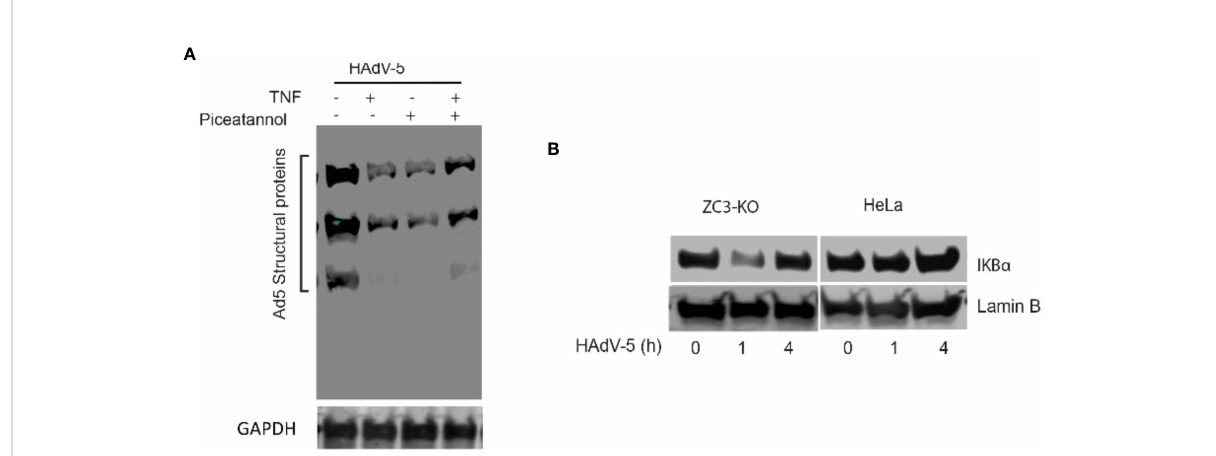
FIGURE 7 Western blot analysis of adenovirus structural protein expression in Hela cells infected with HAdV-5 and treated with TNF-a and/or Piceatannol (A) . Western blot analysis showing the dynamics of IkBa protein expression during the early phase of an HAdV-5 infection (0, 1 or 4 hrs postinfection) in HeLa and ZC3-KO cells (B)